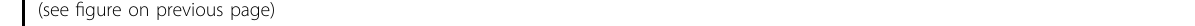
Fig. 1 Isolation of sarbecovirus-neutralizing antibody GW01 from COVID-19 patients. a Binding of fi ve mAbs isolated from COVID-19 patients to the RBD proteins of SARS-CoV-2, RaTG13, GD-Pangolin, GX-Pangolin, and SARS-CoV in ELISA. b Binding af fi nity of GW01 to RBD proteins of SARS- CoV-2, RaTG13, GD-Pangolin, GX-Pangolin, or SARS-CoV was measured by bilayer interferometry experiments. c Neutralization of mAbs against pseudovirus of SARS-CoV-2 and its variants B.1.1.7, B.1.351, B.1.617.1, B.1.617.2, B.1.1.529, and C.37, SARS-CoV, and bat SARSr-CoVs (WIV1 and Rs3367). d Neutralization summary of GW01, S309, and other NAbs against pseudoviruses. e Neutralization of GW01 against authentic SARS-CoV-2 and its